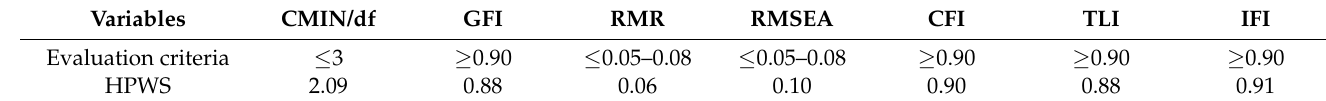
Table 3. Fit indices for the confirmatory factor analysis ( N = 214).